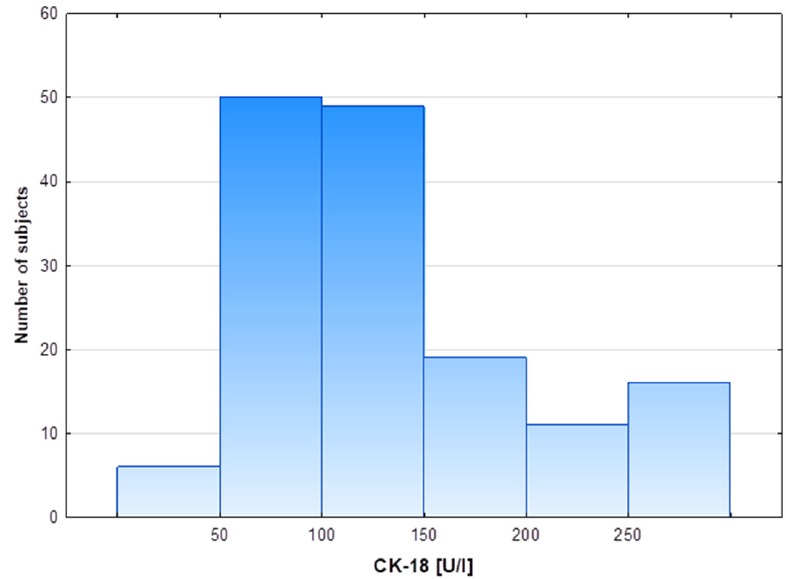
Figure 1. Distribution of cytokeratin-18 plasma levels in the study cohort. Table 1. Characteristics of subjects included in the study: comparison of groups according to the cytokeratin-18 plasma level.